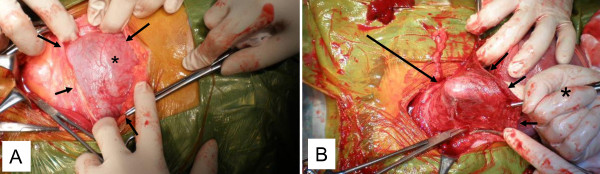
Operative findings during a Cesarean section. A: The asterisk indicates the thin anterior uterine wall. Arrows indicate the peritoneum. The left side of the photograph is the caudal side of the patient. B: After delivering the fetus and removing the placenta, the thin wall was gently pushed from inside the uterus with a finger. The finger tip (large arrow) is clearly visible through the thin wall. The asterisk indicates the surgeon's right hand. Small arrows indicate the uterine incision site.